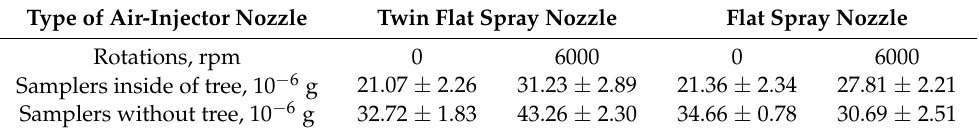
Table 1. Summary dye distribution calculated for three sampler levels.